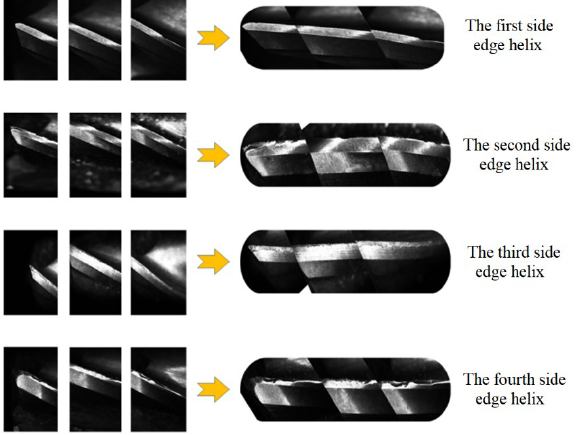
Figure 9. Wear splicing images of different side edges of end mills.